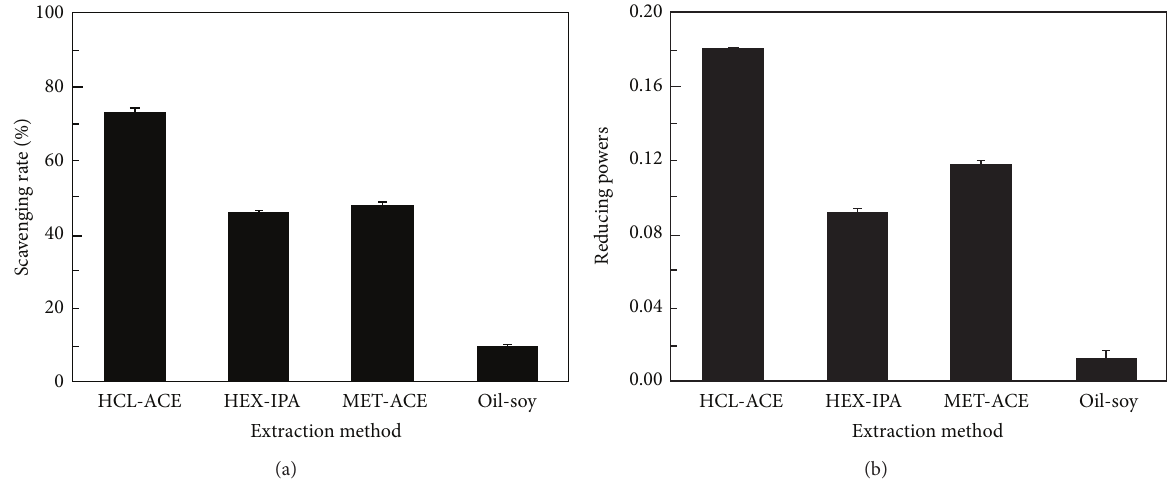
Figure 3: DPPH radical scavenging activities (a) and reducing powers (b) of astaxantin products from H. pluvialis extracted by HCI-ACE, HEX-IPA, MET-ACE, and oil-soy